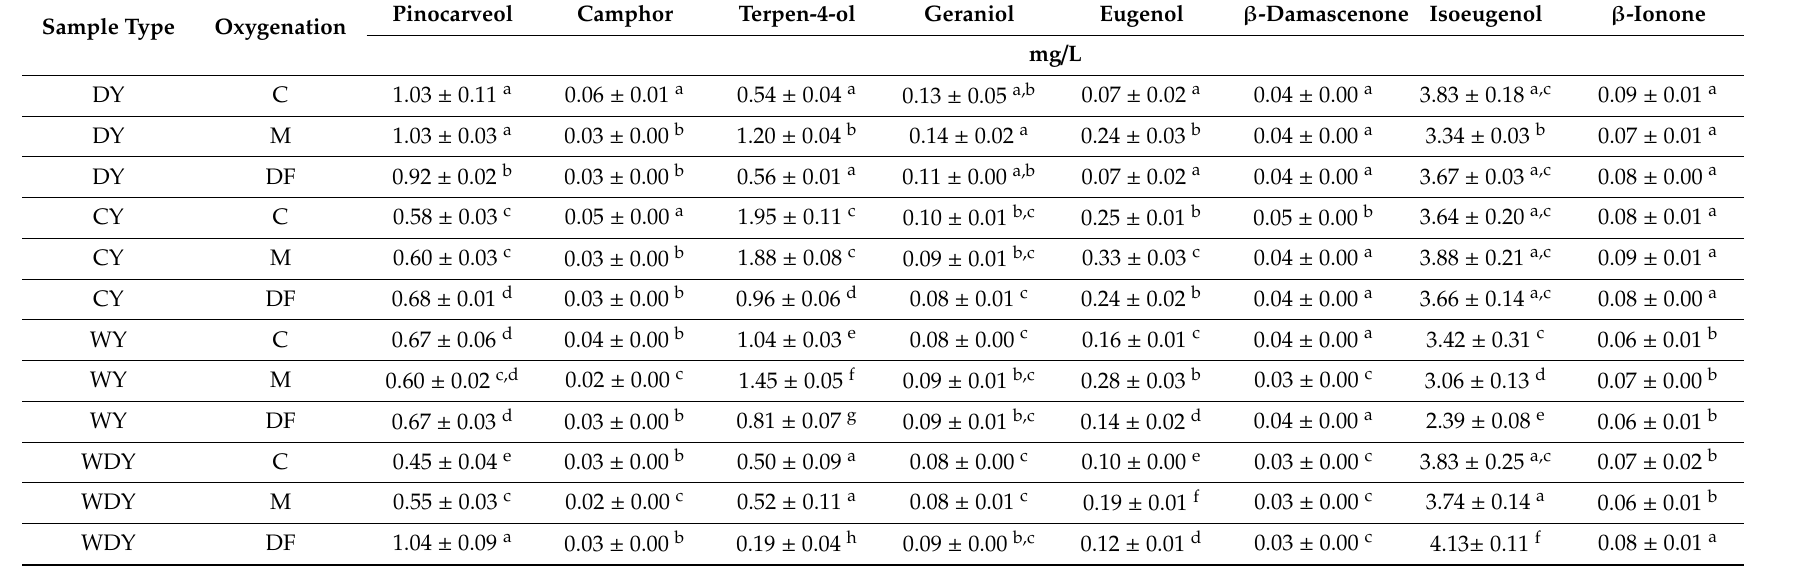
Table 4. Impact of the type of oxygenation on terpenes concentration in